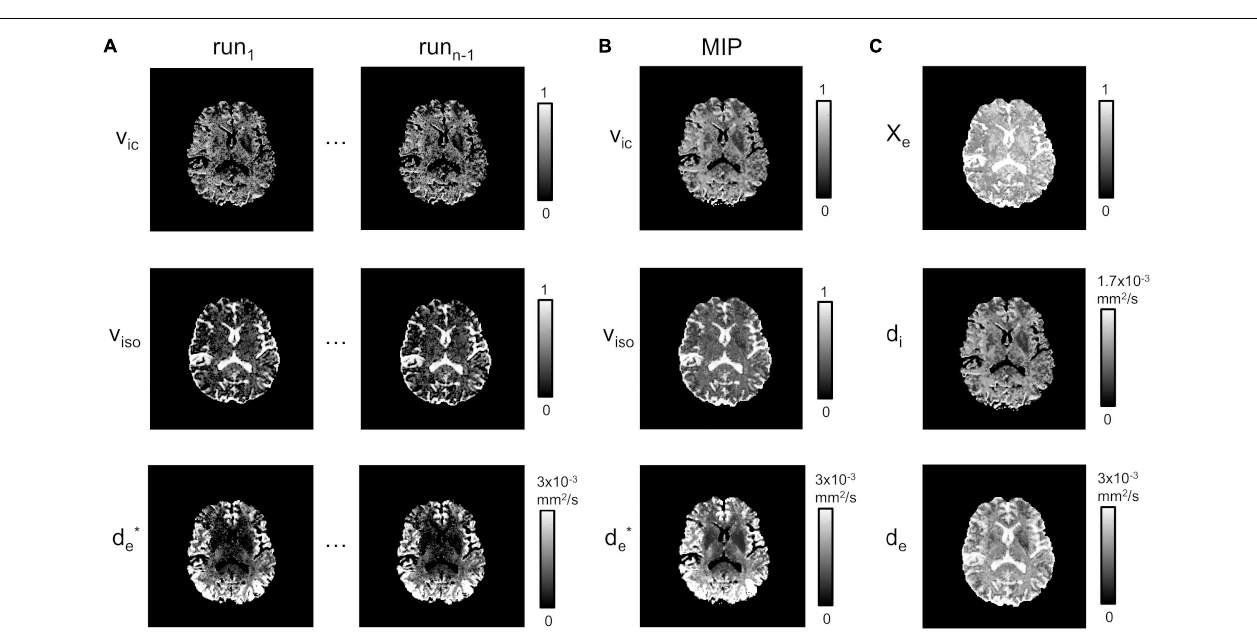
FIGURE 3 | Model estimation. (A) Estimated v ic , v iso and d ∗ e at runs 1 to n-1 . (B) MIP projections for v ic , v iso and d ∗ e (plus Delaunay correction). (C) χ e , d i and d e